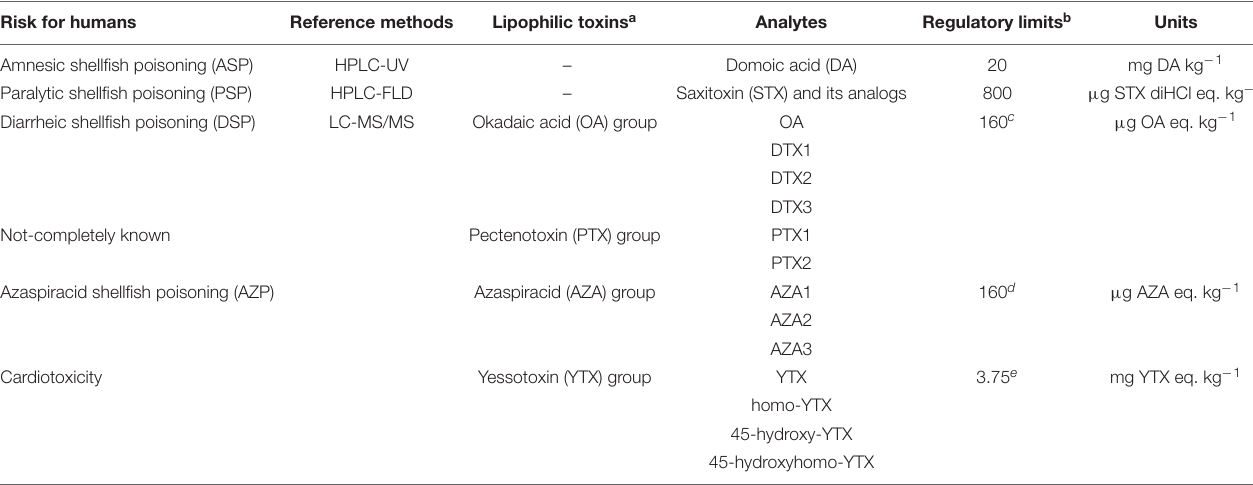
TABLE 1 | Summary of toxins typically analyzed in Europe with the analytical methods and the regulatory limits (maximum quantities allowed in bivalve molluscs placed on the